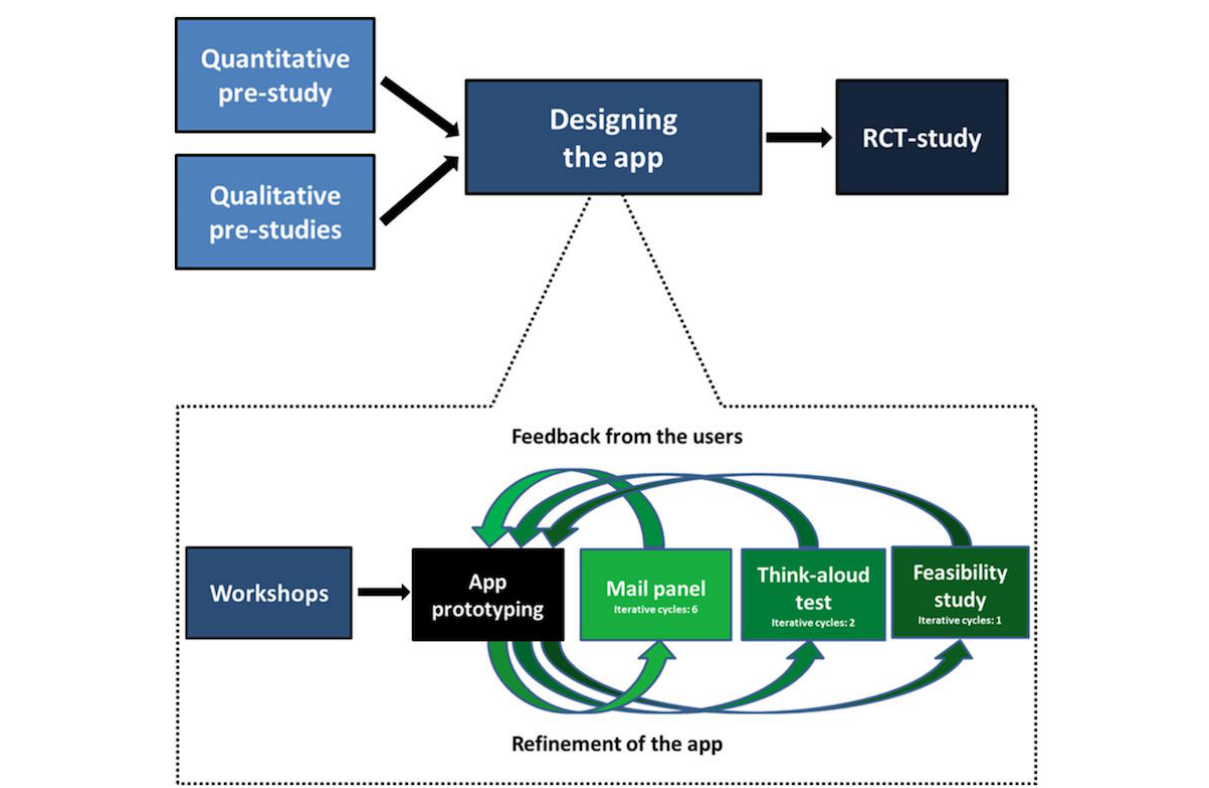
Figure 1. Mixed methods design.